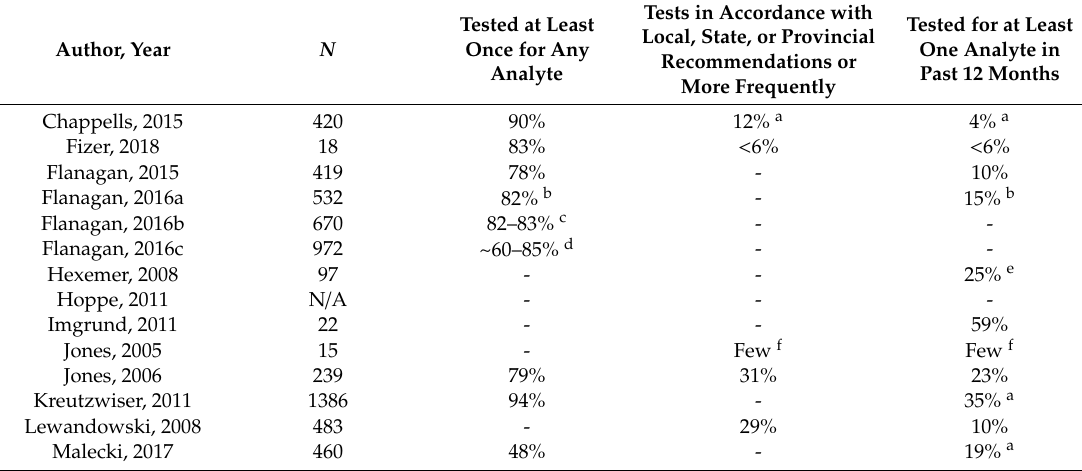
Table 4. Summary of select well testing information from included